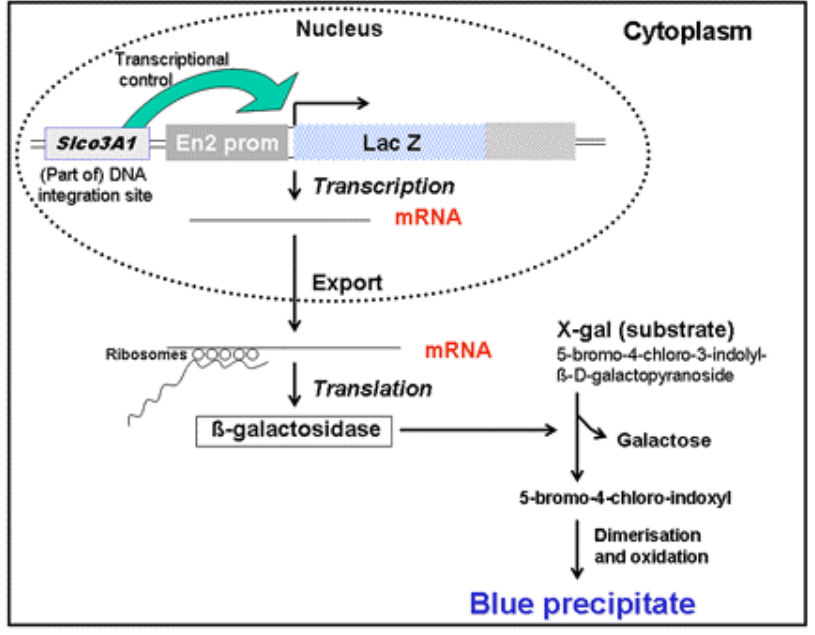
FIGURE 6. Simplified working scheme of the transgenic CCS- lacZ mouse model. The bacterial lacZ reporter gene was placed under the control of engrailed2 promoter elements. Random integration of the construct in the mouse genome resulted in β -galactosidase expression in the cardiac pacemaking and conduction system throughout the heart. β -Galactosidase catalyzes the conversion from X-gal to 5-bromo-4-chloro-indoxyl, which is visible after nonenzymatic dimerization and oxidation as a blue precipitate in the cells in which the reporter gene is expressed. As expression in the CCS was not observed in a number of additional lines of mice harboring the same transgenic construct, it is likely that the lacZ expression is under the transcriptional control of an unknown locus at the site of integration, rather than of the En-2 regulatory elements within the construct. Further study indicated that regulatory elements from the gene Slco3A1 influence CCS-restricted reporter gene